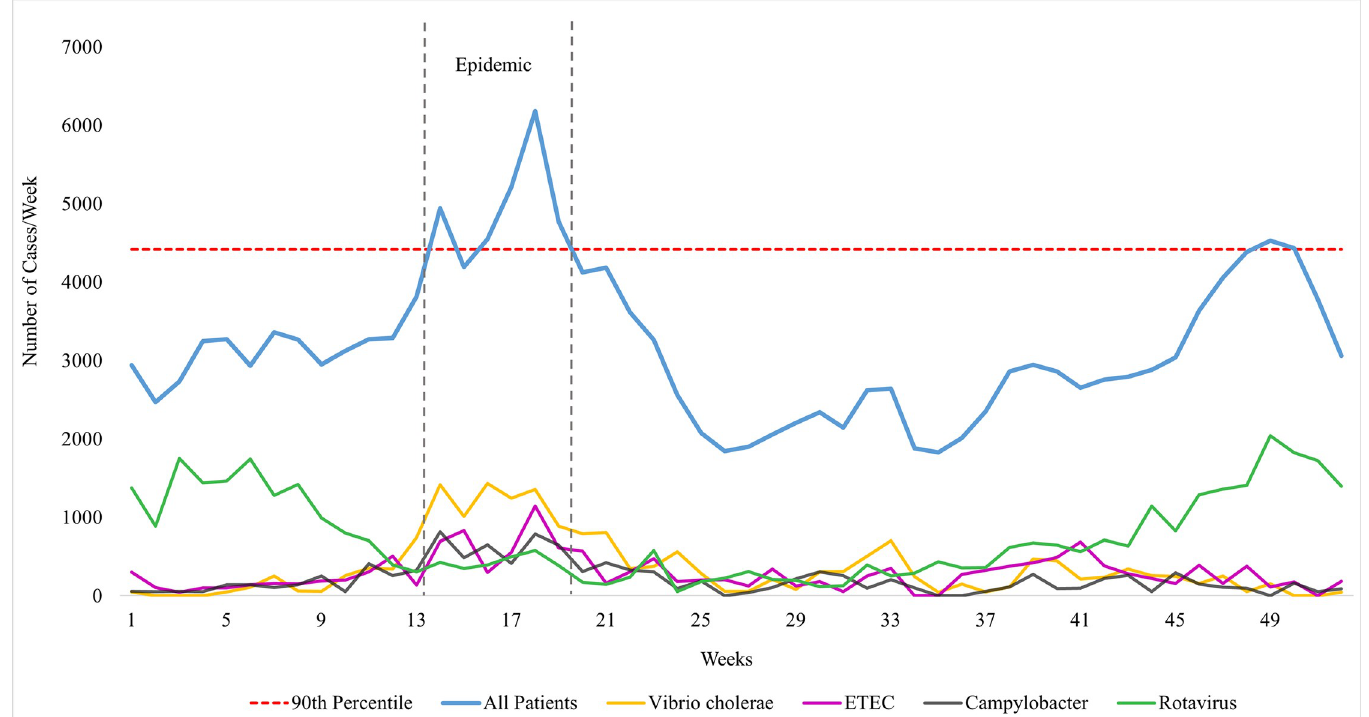
Fig 1. Total patient visits and patients with selected enteric pathogens detected in stool samples per week at icddr,b Dhaka Hospital in 2018. The horizontal dashed line represents the 90 th percentile of total patient visits per week in 2017 and 2019. The vertical dashed lines indicate the diarrhea epidemic period (April 2 to May 12) in 2018. ETEC, enterotoxigenic Escherichia coli